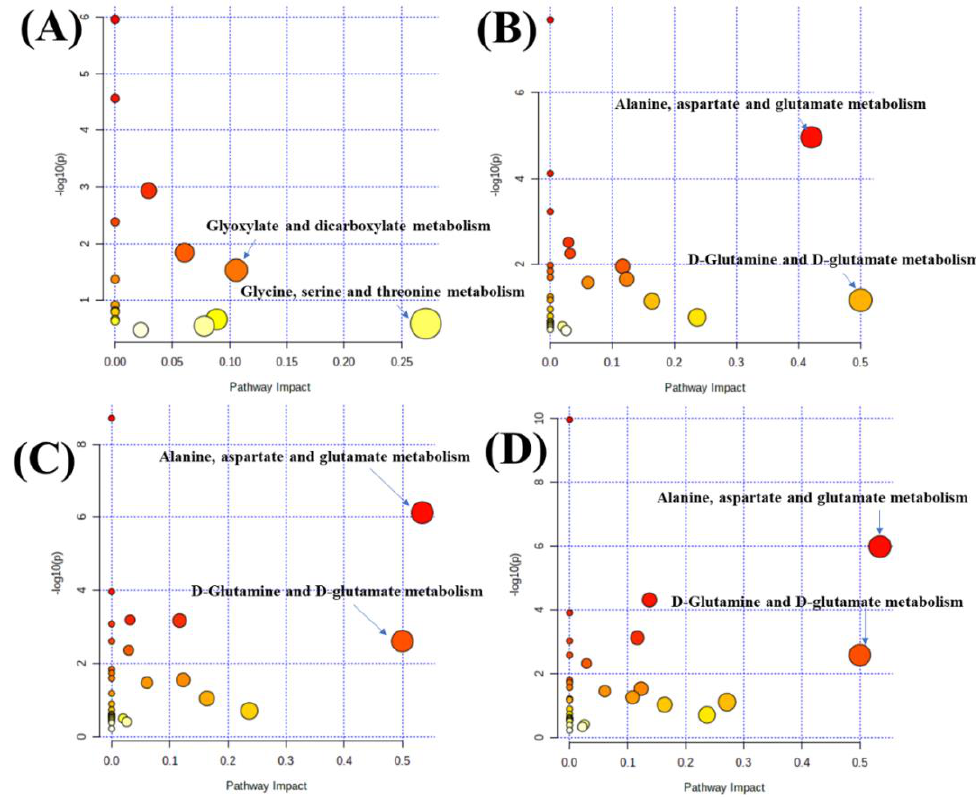
Figure 9. Overview of pathways related to the differential endogenous metabolites in different treated groups: ( A ) polysaccharide knockout component of crude AB-treated group, ( B ) polysaccharide knockout component of salt-processed AB-treated group, ( C ) polysaccharide component of crude AB-treated group, ( D ) polysaccharide component of salt-processed AB-treated group. Glycolysis is an important part of carbon flux in cell proliferation [23]. Lactate is the terminal product of glycolysis. Citrate and succinate are intermediate products of the citrate cycle. Compared with the model group, the levels of lactate, citrate, and succinate in the sAB-, ABP-, and sABP-treated groups were decreased. This phenomenon can be explained by the bone resorption of osteoclasts consuming a large amount of energy, which causes the speed up of glycolysis and oxidative phosphorylation [24]. With the enhancement of energy metabolism, the tricarboxylic acid cycle (TCA) is also enhanced. As an important intermediate product of the TCA, the concentrations of citrate and succinate in serum is largely increased. This finding is consistent with that of previous studies [25]. The decrease of the lactate, citrate, and succinate levels in the treated groups demonstrated that the glycolysis and TCA cycle of OVX rats was shifted to the normal state after treatment. In the model group, a large amount of glucose was consumed, and the glucose concentration in serum became lower. To compensate for the large consumption of glucose, glycogenic amino acids (i.e., serine, glycine, alanine) tend to participate into the glycolysis process